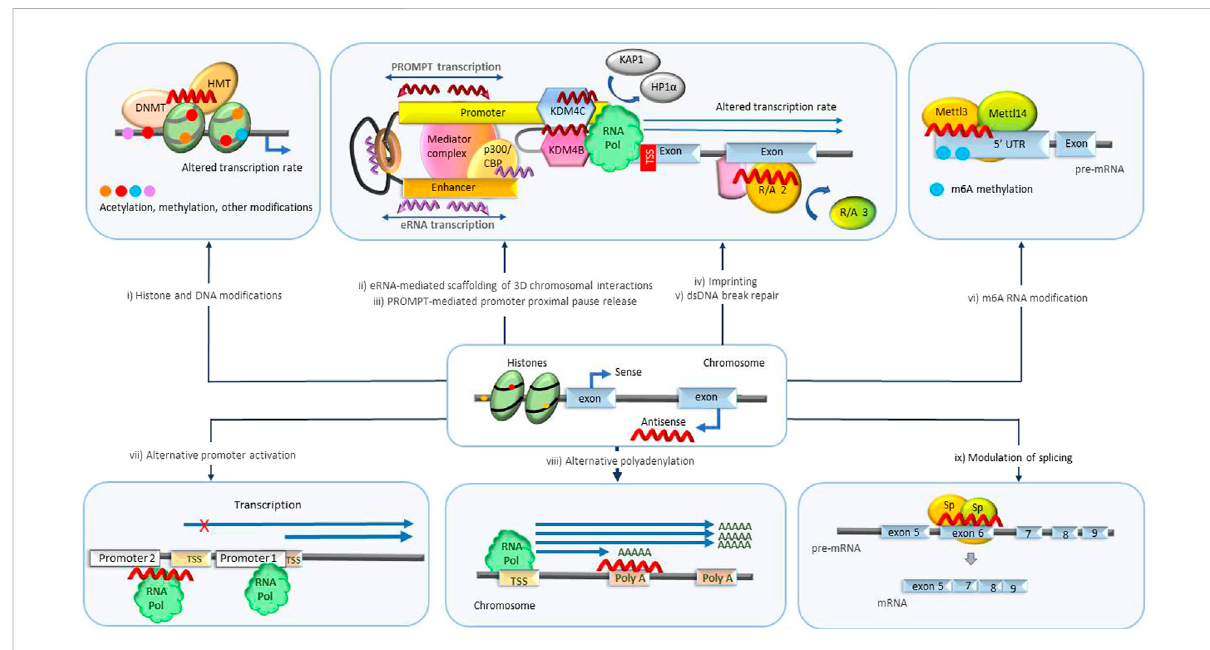
FIGURE 2 Transcriptional level biological processes regulated by NATs. (i) Histone and genomic DNA modi fi cation. NATs bound to speci fi c loci in DNA scaffoldepigeneticregulatoryenzymessuchasDNAmethyltransferases(DNMT)andhistonemodi fi ersthatmediateacetylationandmethylationand initiate imprinting and changes in transcription rate. (ii) eRNA scaffolding 3D chromosomal interactions. eRNAs maintain the chromatin active state and mediate the enhancer-promoter looping by serving as decoys or otherwise modulating the functions of participating protein complexes such as BRD4, CBP, NELF, cohesin, Mediator complex and others leading to changes in transcription rate and mRNA abundance. (iii) PROMPT- mediated promoter-proximal pause release. PROMPTS initiate histone modi fi cations by recruiting various epigenetic modi fi ers (KDM4B, KDM4C) triggering destabilization of protein complexes (HP1 α , KAP1) involved in promoter-proximal Pol II pausing, resulting in release of Pol II and increased transcription. (iv) Imprinting. NATs scaffold/decoy/block different repressor and activator proteins catalyzing transcription repression of speci fi c parental alleles. (v) DNA damage repair. NATs scaffold/decoy proteins involved in double-stranded DNA break repair. (vi) m6A RNA modi fi cation. NATs mediate m6A modi fi cation of speci fi c RNA molecules by recruitment of regulators or enzymes associated with methyltransferase complexes (Mettl3/Mettl14) or m6A demethylases (ALKBH5). m6A modi fi cation alters availability and processing of RNAs. (vii) Alternative promoter activation. NATs alter the transcription rate of speci fi c isoforms by antagonizing or activating alternative promoters. (viii) Alternative polyadenylation. NATs repress/activate polyA signals prompting transcription of alternative isoforms. ix) Modulation of splicing. NATs modulate the target binding and activityofsplicingpromoting/inhibitingfactors(Sp)facilitatingproductionofspeci fi cisoforms.DNMT,DNAmethyltransferase;HMT,histonemethyl transferase; eRNA, enhancer RNA; CBP/p300, CREB binding protein; PROMPT, promoter upstream transcripts; KDM4B/4C -lysine speci fi c demethylase 4B/4C; UTR, untranslated region; m6A, N6-methyladenylation; TSS, transcription start